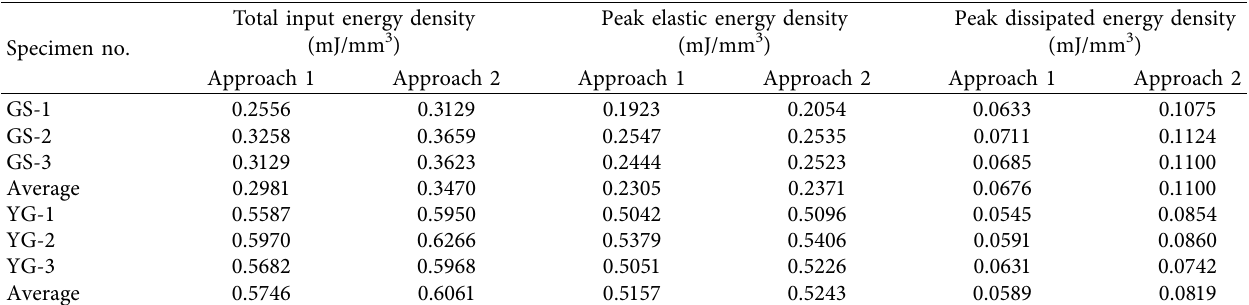
Table 6: Calculation results of peak energy density of